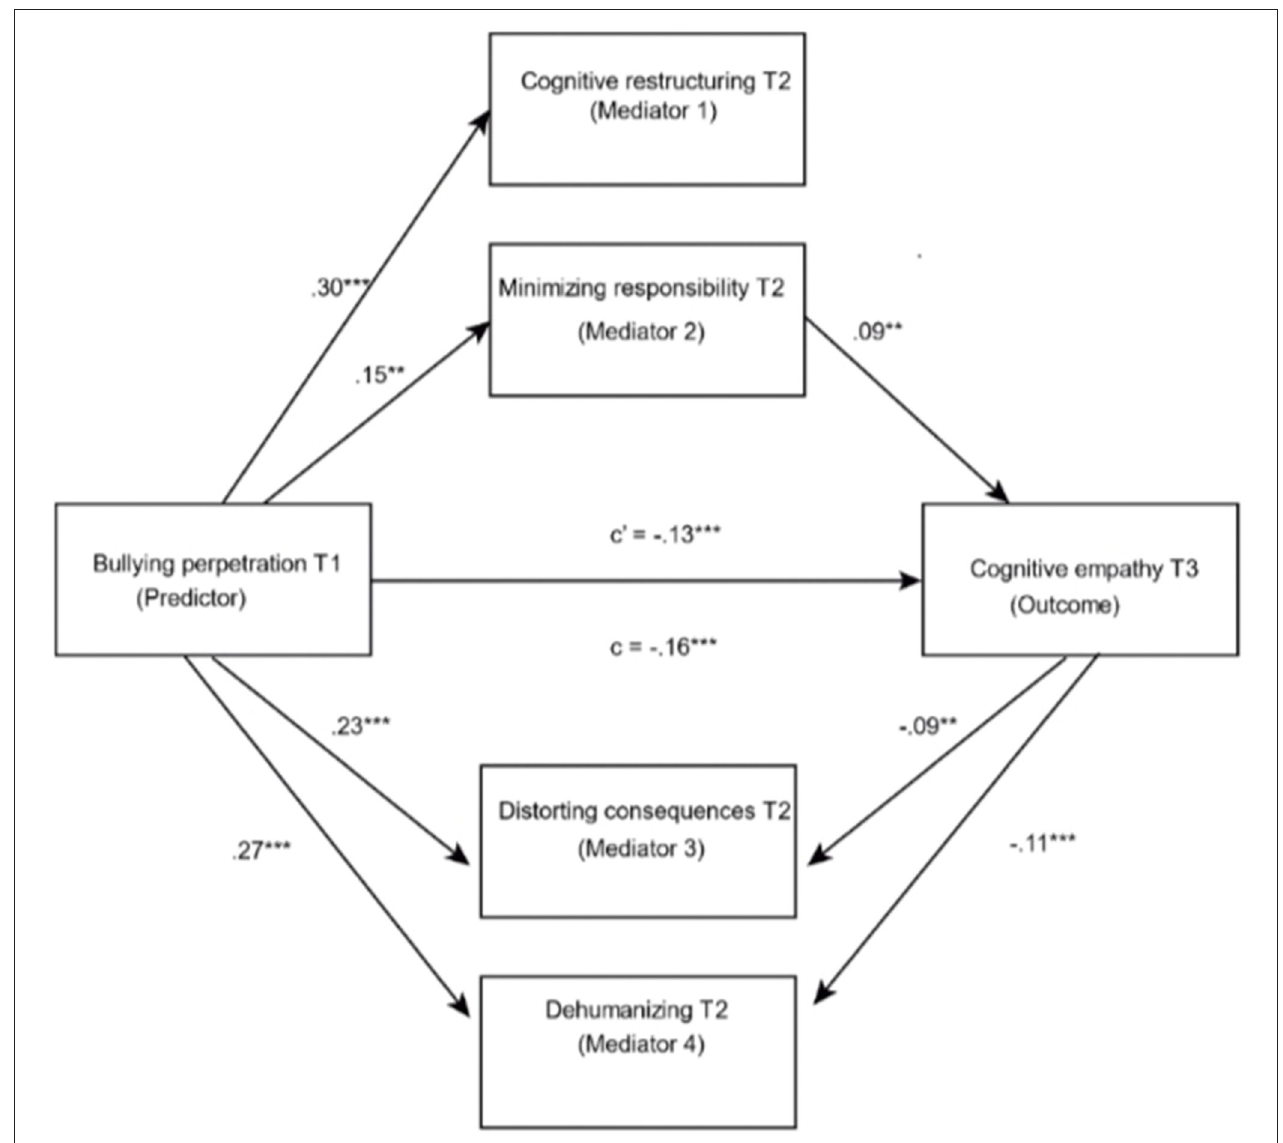
FIGURE 1 | Results in the pathways of the model. ** p < 0.01; *** p < 0.001.